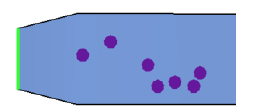
Figure 8. Change export width as α